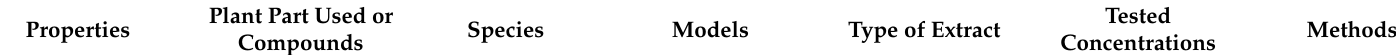
Table 4. In vitro biological and pharmacological activities of various pitaya extracts and pure